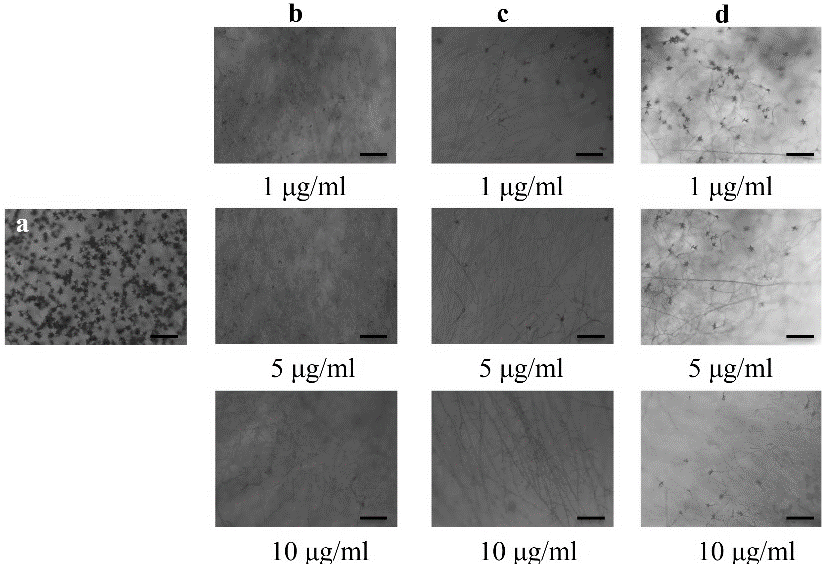
Figure 3. Effects of bonactin, feigrisolide C, and Nativo ® WG75 on suppression of conidiogenesis of M. oryzae Triticum isolate BTJP 4 (5) in the 96-multiwell plates at 1 µg/mL, 5 µg/mL, and 10 µg/mL. Image ( a ) control. Images in panels ( b – d ) are bonactin, feigrisolide C, and Nativo ® WG75, respectively. Bar = 50 µm.